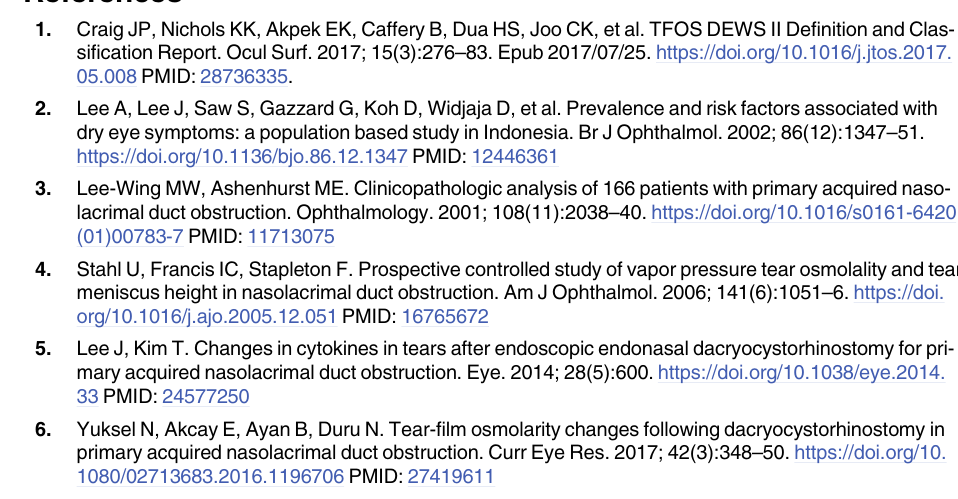
S1 Table. Data for all subjects included in this study showing clinical results.